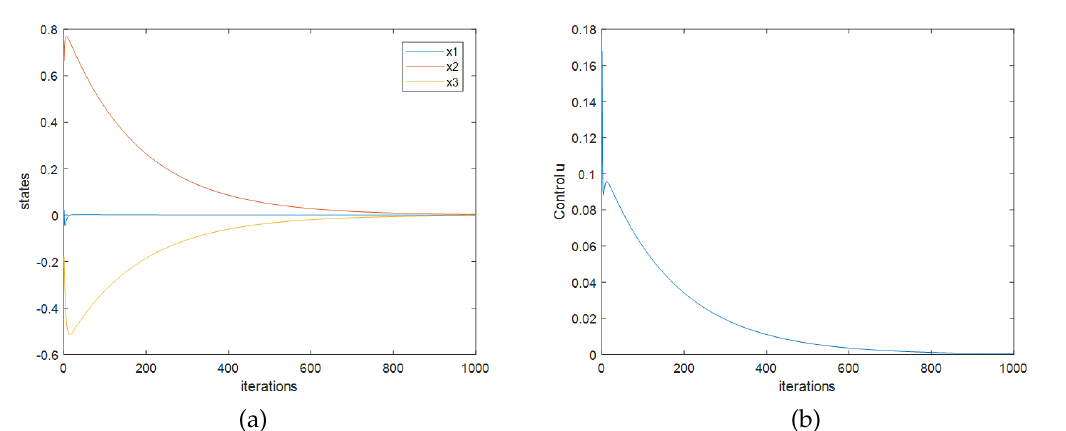
Figure 2. Closed-loop response and the control effort of system 1. ( a ) Trajectories of state values. ( b ) Trajectory of control value.